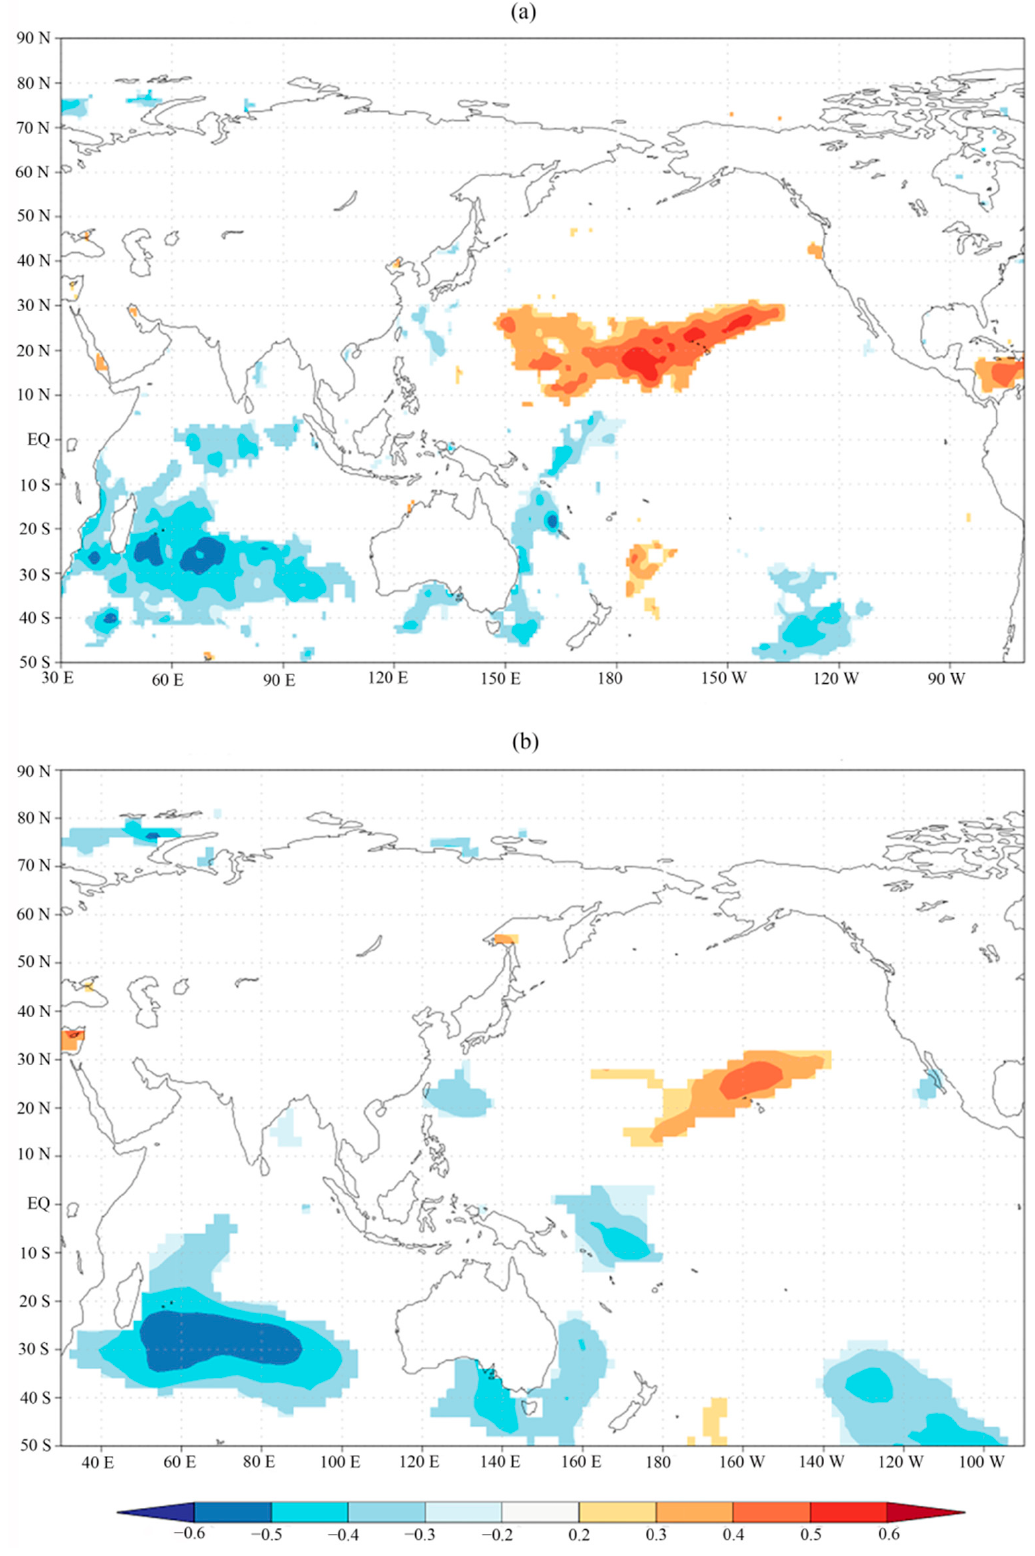
Figure 10. Spatial correlation patterns between the PC1 series and the ( a ) June–July averaged HadISST 1 SST (1951–1994 CE) and ( b ) June–July averaged ERSST v5 SST (1951–1994 CE). Correlations not significant at the 90% level have been masked out on the map.